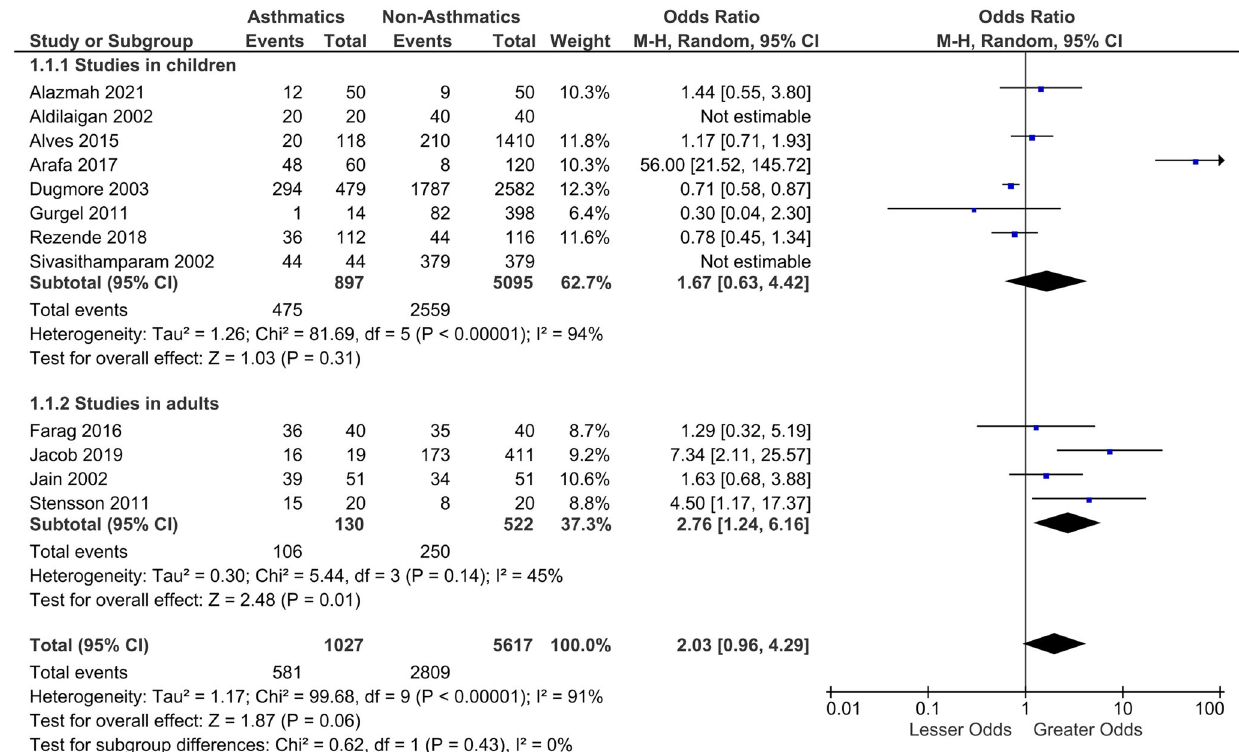
Fig. 2 Forest plot. Diagram depicting the association between asthma and dental